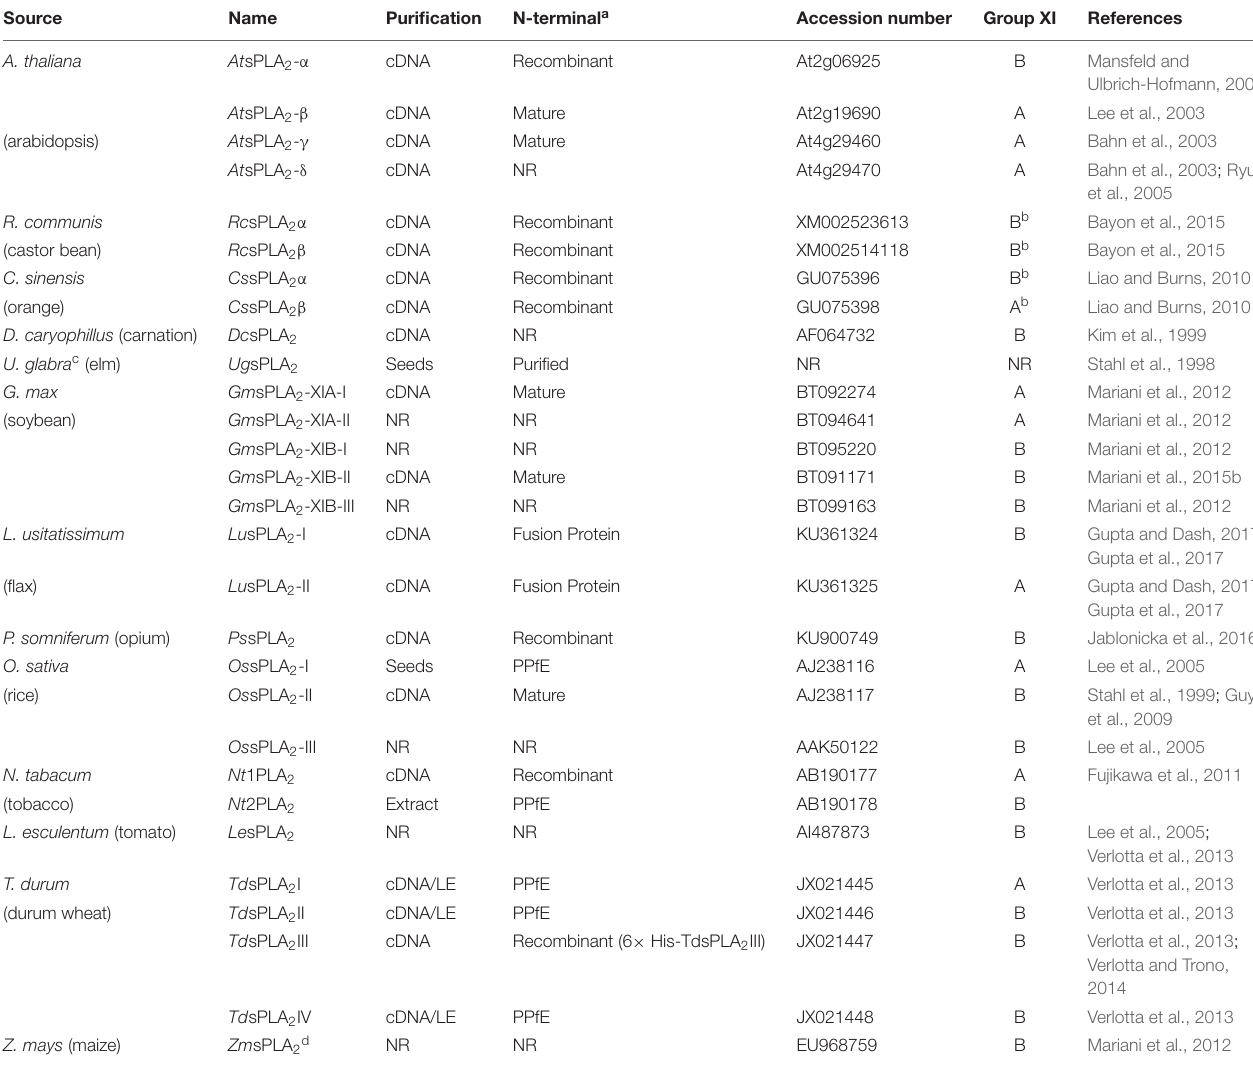
a Mature, without extra amino acids at the N-terminus after heterologous expression. PPfE, when the enzyme was Partially Purified from Extracted from a plant organ (partial purification, less than 90% purity). LE, leaves extract. Recombinant is indicated when, according to the reported data, it is not known if the expression assayed is in mature form or contain any tags in the final purified recombinant form (no clearly indicated in the original paper). b Classified in this review from proper alignment of the reported sequences. NR, not reported. c For sPLA 2 from Ulmus glabra (elm) it was assigned as UgsPLA 2 since in the original describing paper (Stahl et al., 1998) was named as sPLA 2 without initial letters of identification. d Named as ZmsPLA 2 in this